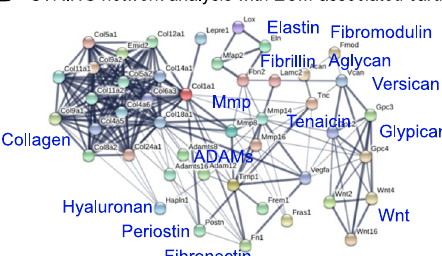
Figure 4. The cardio-JAGs exhibit a distinct gene expression profile. ( A ) Filtration and identification of cardio- JAGs from the comprehensive transcriptome analysis in the cardiomyocytes of the differently-aged mice. ( B ) The GO analysis with the cardio-JAGs. ( C ) The GSEA with the transcriptome in the cardiomyocytes. ( D ) The STRING network analysis with the extracellular matrix (ECM)-associated